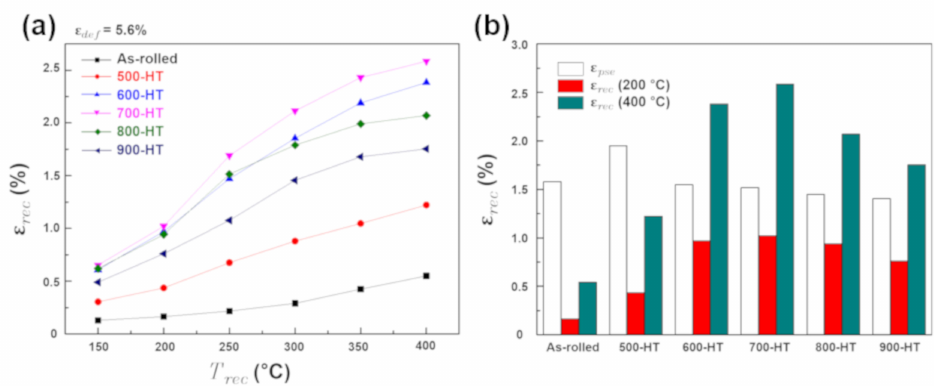
Figure 6. ( a ) Evolutions of shape recovery strains with heating temperatures for different heat-treatment conditions; and ( b ) pseudoelasticity, and shape recovery strains, at 200 ◦ C heating and 400 ◦ C